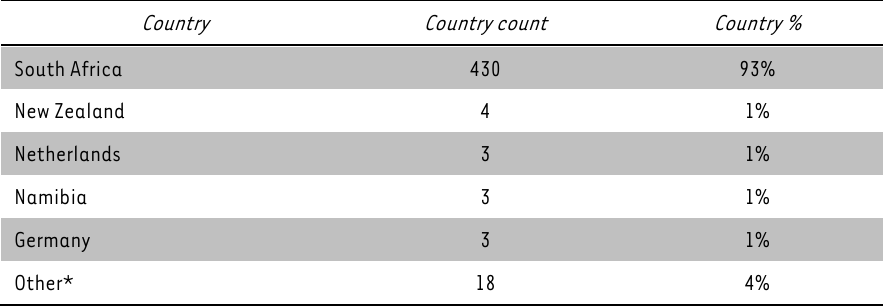
TABLE 5: Top contributing countries Country Country count Country %